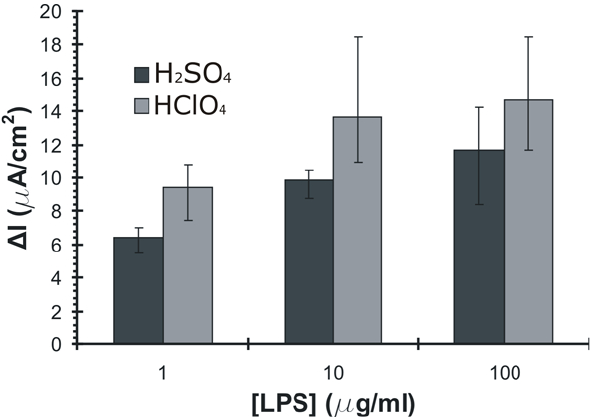
Figure 6. Influence of the pre-treatment solutions in the LPS detection. Change of the measured current in the two types of electropolished sensors due to the LPS interaction with the PmB (100 µ gmL − 1 ) immobilized via